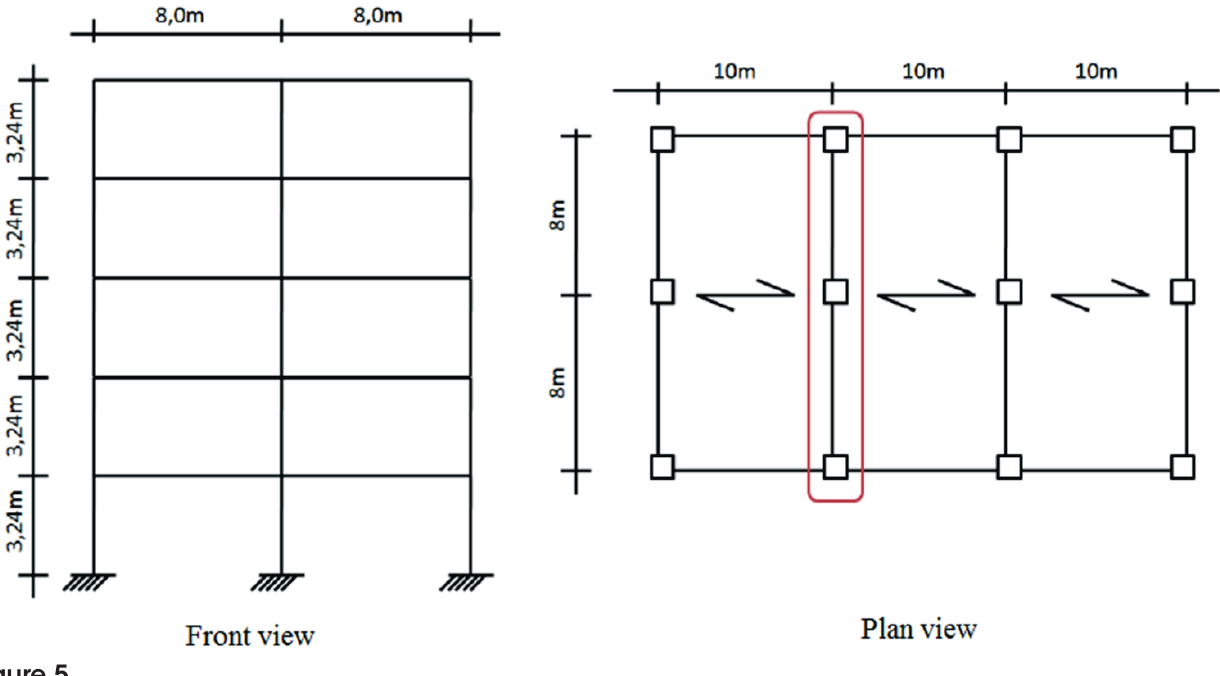
Figure 5 Dimensions of the base module of the frame, Meireles Neto